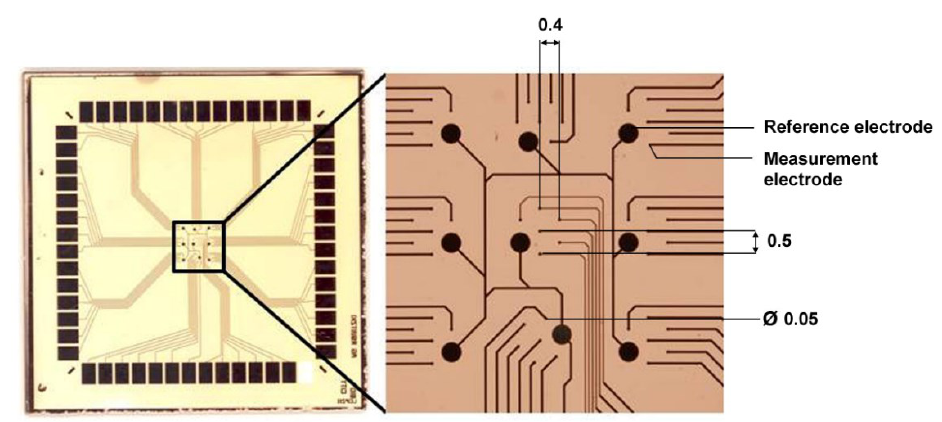
Figure 2: 1w54e-Microelectrode array with 54 measurement electrodes in a single well format. Arrangement of electrodes with diameter and horizontal and vertical spacing shown in